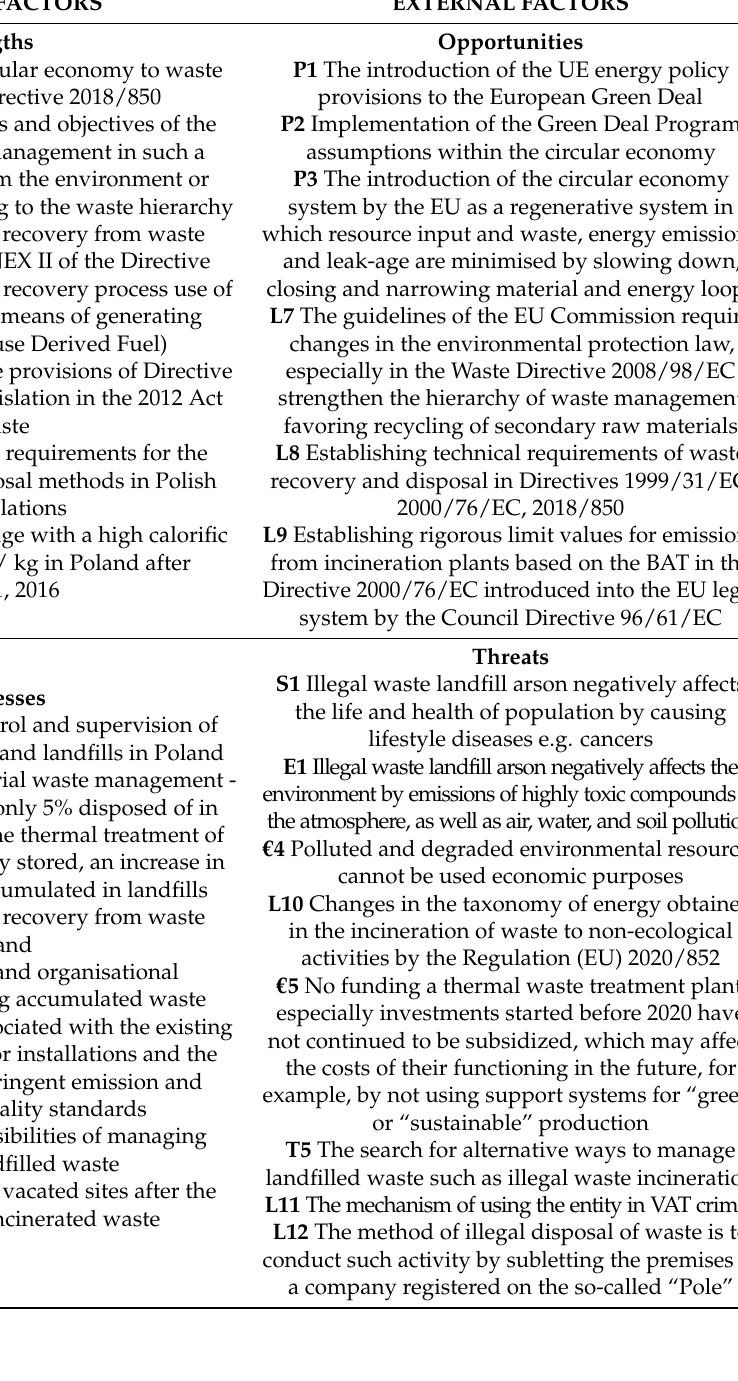
Table 7. SWOT analysis for the industrial waste management according to PESTEL analysis classify- ing: political (P), economic ( € ), social (S), technological (T), environmental (E) and legal (L) factors. INTERNAL